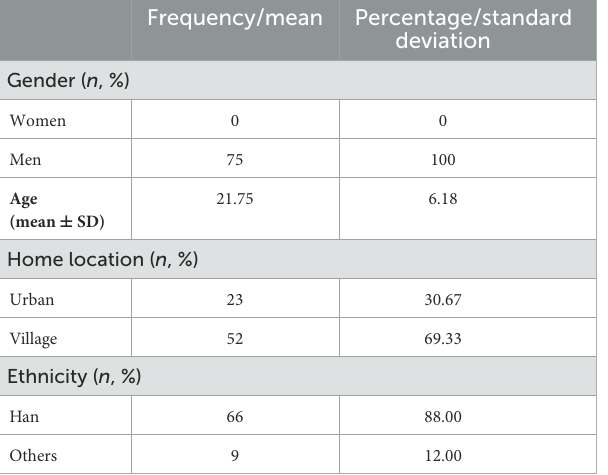
TABLE 5 Demographic information of the 75 participants who participated in the EEG study ( n = 75). Frequency/mean